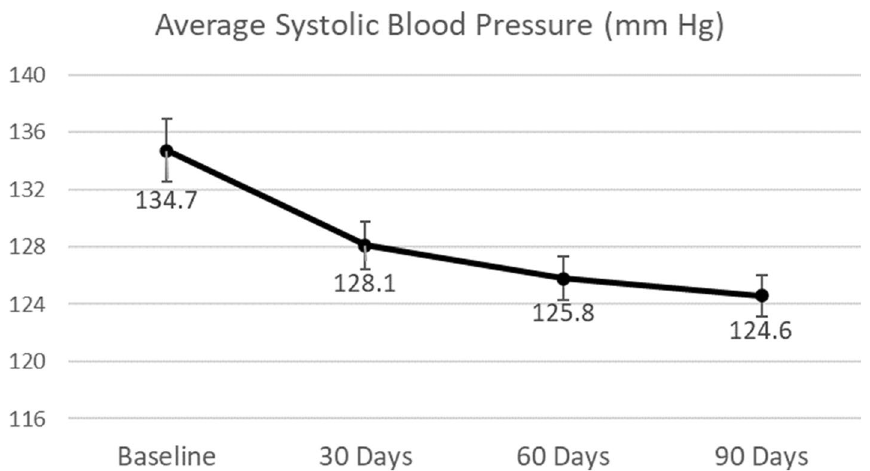
Figure 1. Changes in systolic blood pressure. Vertical bars represent standard